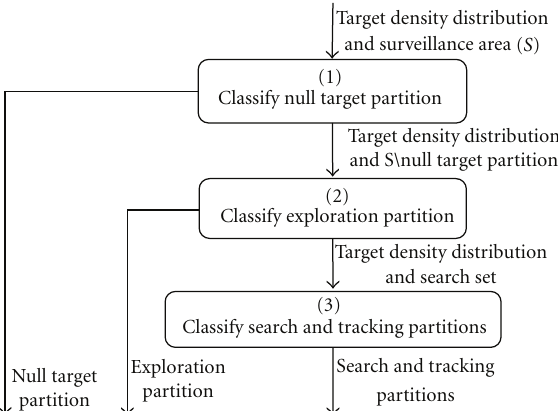
Figure 6: Cascade of classifiers that partition the surveillance area into (1) a null target partition, (2) an exploration partition, and (3) a set of search and tracking partitions. Note that at each instance of time that the target density distribution changes, this classifier is processed on the new target density distribution. In this sense partitions change with